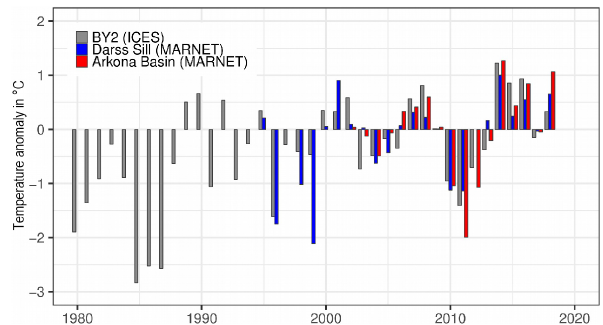
Figure 2. Annual mean sea surface temperature anomalies rela- tive to the reference period 2002–2018 from de-seasonalised mea- surements at the Arkona Deep monitoring station and the MAR- NET stations (Darss Sill and Arkona Basin) in the period 1980– 2018. (Source: Meier et al., 2022b; their Fig. 20 distributed un- der the terms of the Creative Commons CC-BY 4.0 License, http://creativecommons.org/licenses/by/4.0/, last access: 4 February